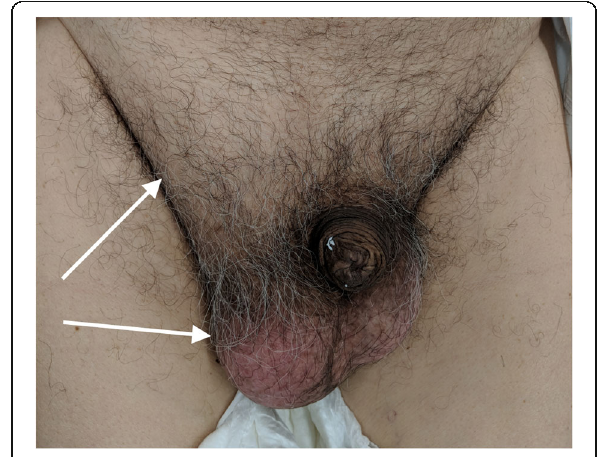
Fig. 1 Pre-operative inguinoscrotal hernia. White arrows point to the right-sided inguinoscrotal